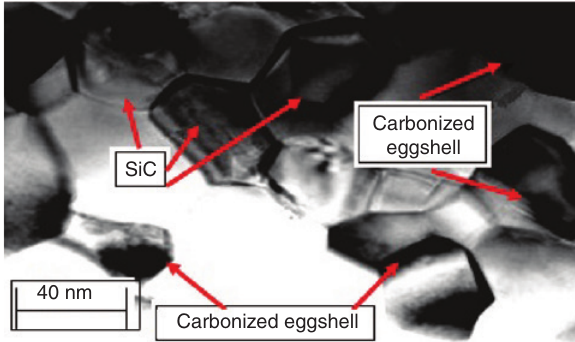
Figure 9: TEM image of sample designation G3-AA2014/2.5% SiC/7.5% eggshell